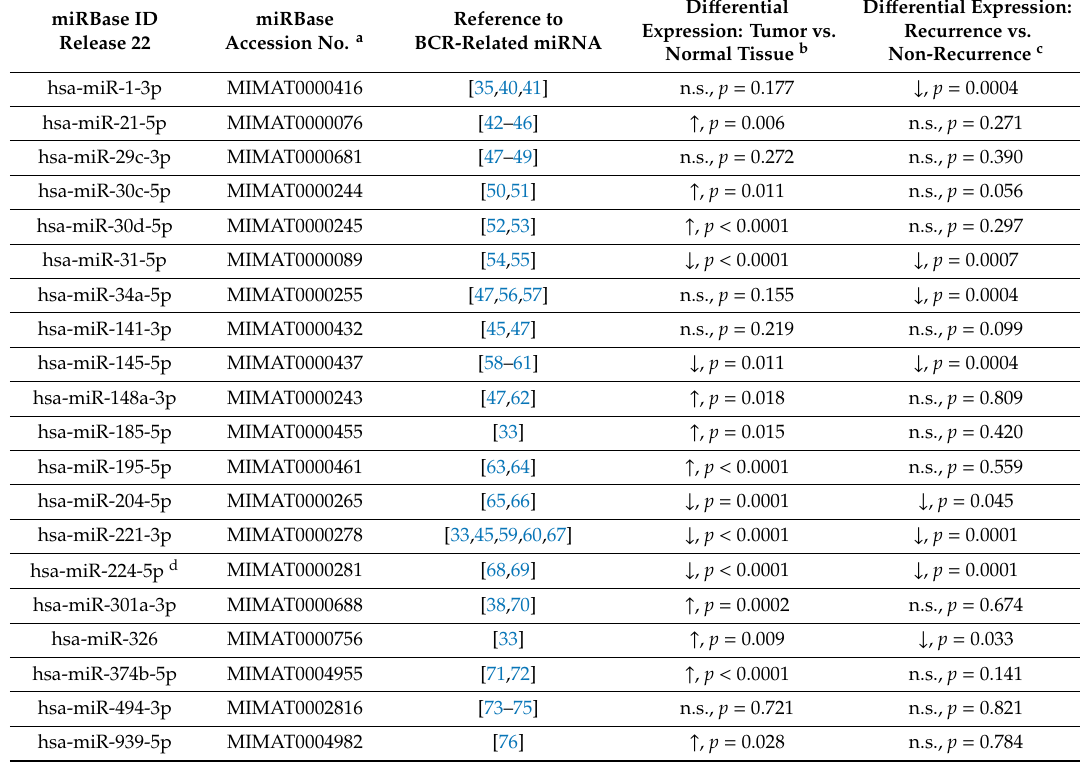
Table 2. MicroRNAs analyzed in this study. The selection of microRNAs was based on a previous systematic review of studies with microRNAs as potential BCR predictors after RP [34] and / or on other study data after the publication of the